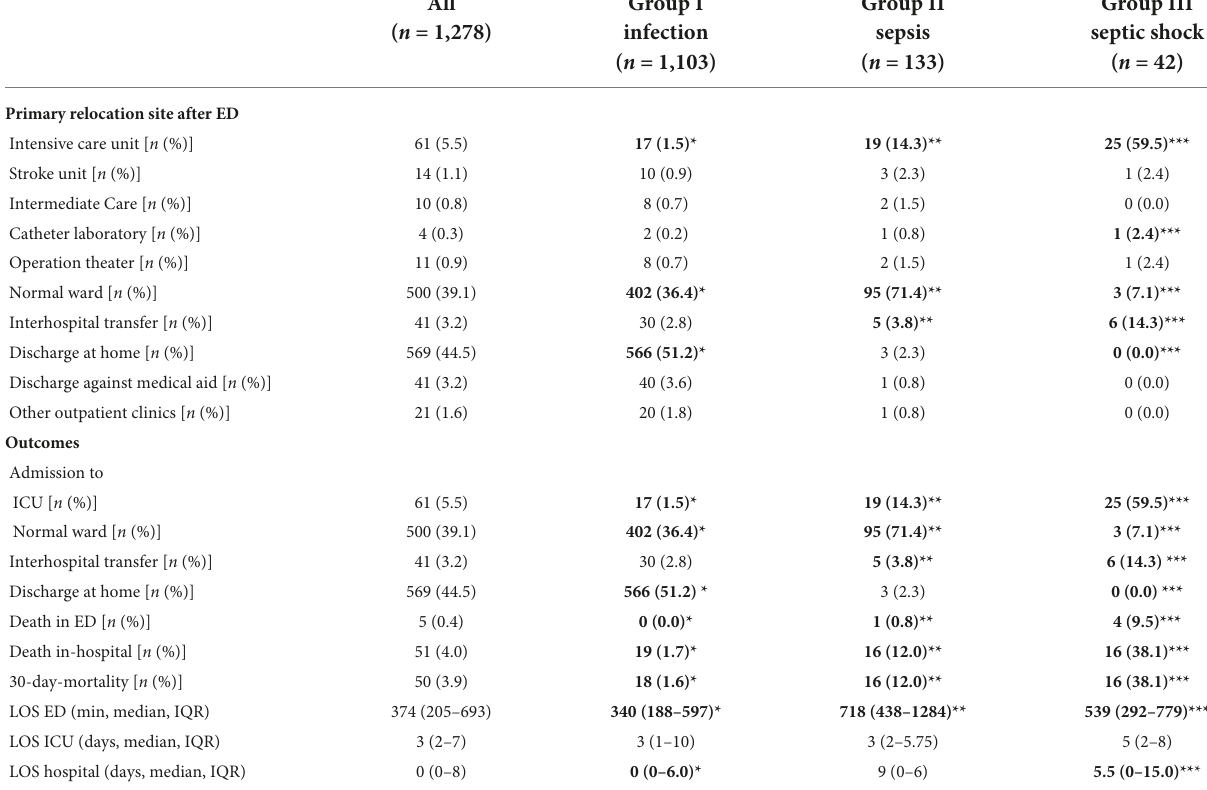
TABLE 3 Relocations sites and outcomes of the patients suffered from infection, sepsis, and septic shock in the emergency department.